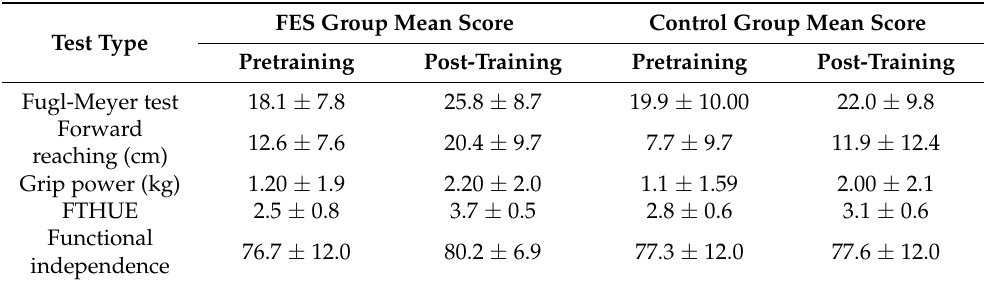
Table 7. Improvement analysis of UL